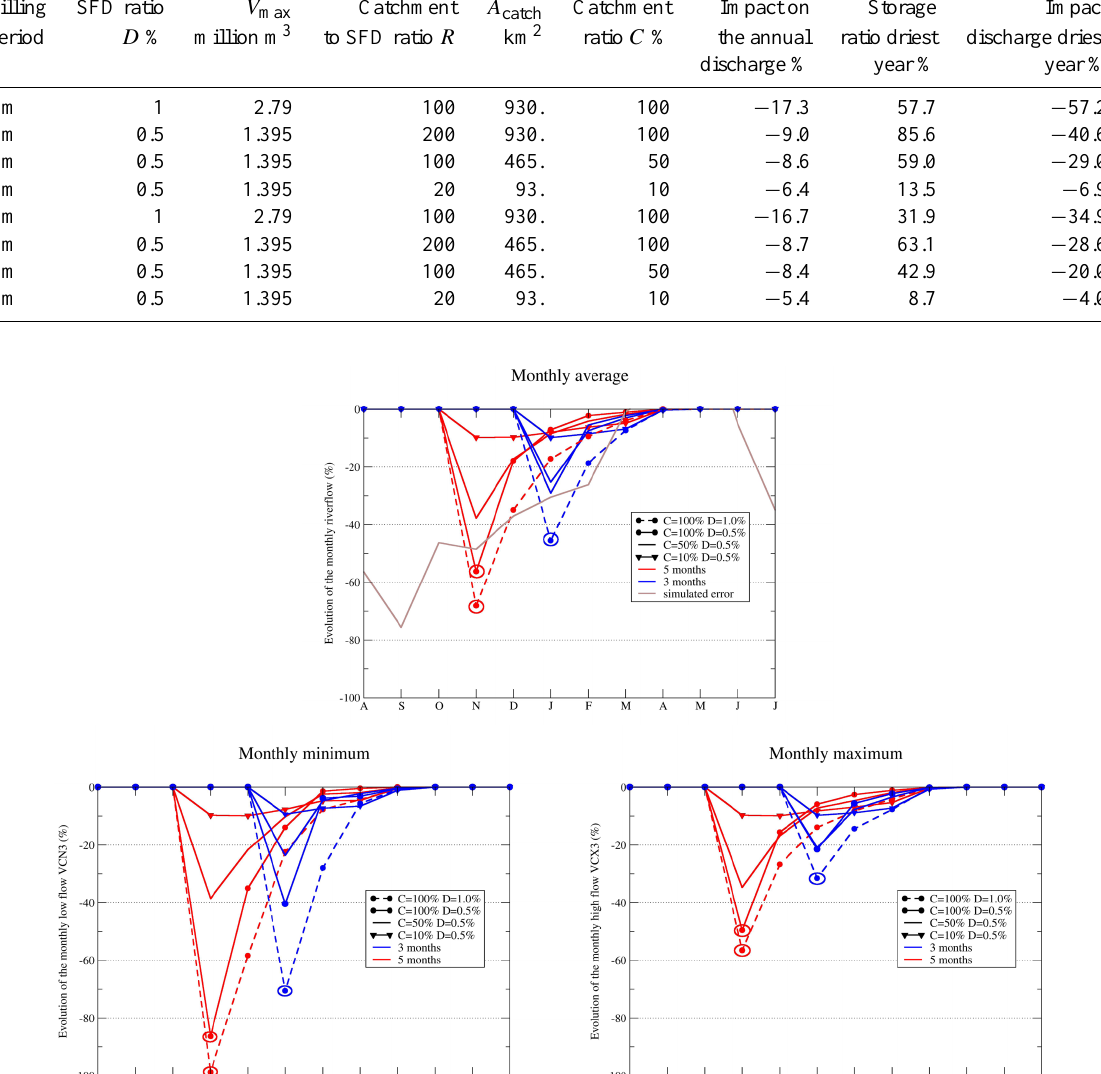
Figure 5. Impact of the irrigation dams on the mean monthly river flow (top), mean monthly low flow (bottom left) and mean monthly high flow (bottom right) of the Layon River at St Lambert according to the filling period (3 or 5 months), the spatial extent of the dams ( D =1 or 0.5%) and the size of the filling catchments ( C =10, 50 or 100%). The grey line represents the error on the monthly discharge of the 10-year reference simulation. A circle indicates that the impact is significant at